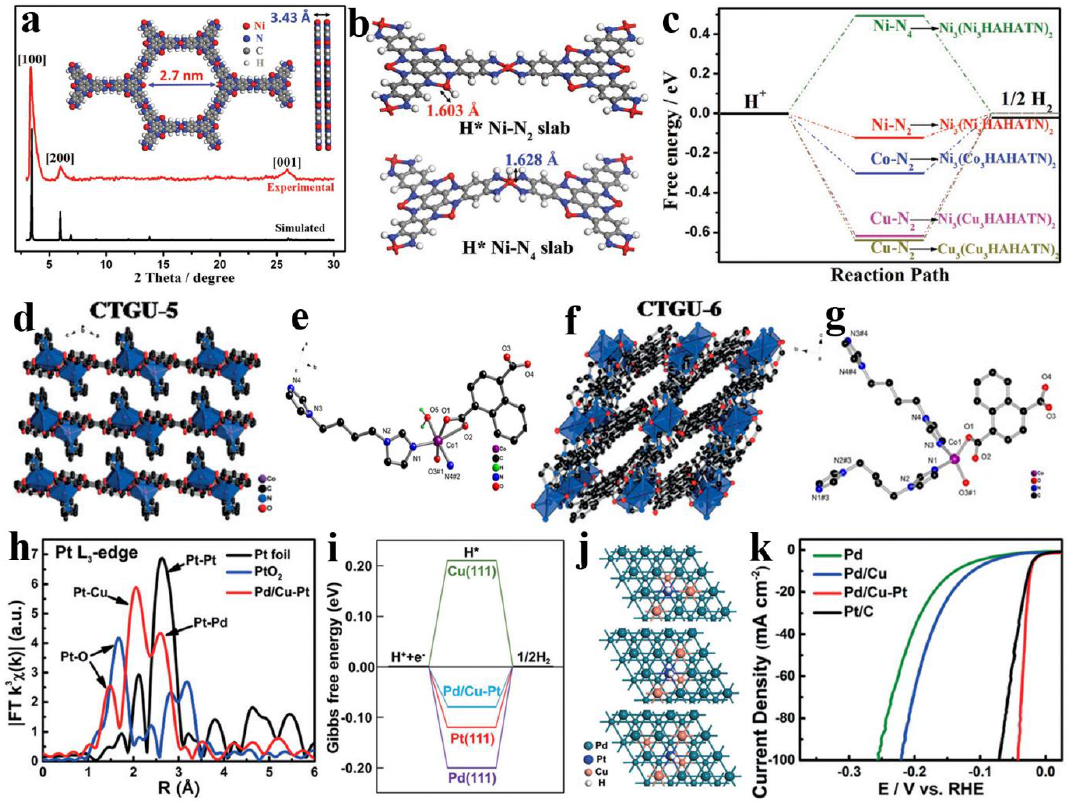
Figure 5. ( a ) Experimental and simulated PXRD patterns of Ni 3 (Ni 3 ∙HAHATN) 2 . ( b ) Hydrogen adsorption slabs. ( c ) Free energy profiles for the HER over the electrocatalytic sites. Reprinted with permission from ref. [80]. Copyright (2020) The Authors. Published by Wiley−VCH Verlag GmbH & Co. KGaA, Weinheim. The crystal structure diagrams and the corresponding asymmetric unit for ( d , e ) CTGU−5 and ( f , g ) CTGU−6. Reprinted with permission from ref. [81]. Copyright (2017) Wiley−VCH Verlag GmbH & Co. KGaA, Weinheim. ( h ) k 3 −weighted χ(k)−function of the EXAFS spectra for the Pt L 3 −edge. ( i ) The free energy diagram. ( j ) Models for the Pd/Cu−Pt NRs. ( k ) LSV curves. Reprinted with permission from ref. [84]. Copyright (2017) Wiley−VCH Verlag GmbH & Co. KGaA, Weinheim. MOF materials are often used as precursors to obtain catalysts with atomically dis- persed products, while the direct use of the MOF as the HER electrocatalysis for the hy- drogen evolution is less reported. The majority of the catalytic activities toward the MOF are hardly similar to those of the materials composed of carbon and metal. However, the well−defined metal nodes with a coordination environment and a customizable structure of the MOF can be an ideal platform to study the catalytic activity centers. 4. Summary and Outlook The SACs catalyst with an asymmetric local coordination and a flexible adjustment of the coordination configuration was rapidly expended in the HER catalysis as com- pared to the traditional M−N 4 sites, which resulted from their unique electronic and geometric structure (Table 1). Table 1. The comparison of the HER performance of the carbon−based SACs with the different ac- tive sites. Catalyst